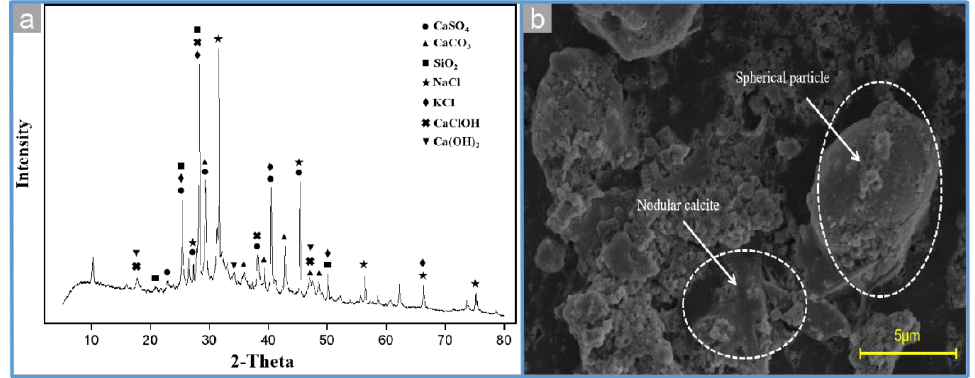
Figure 2. XRD patterns ( a ) and SEM images ( b ) of MSWI fly ash.